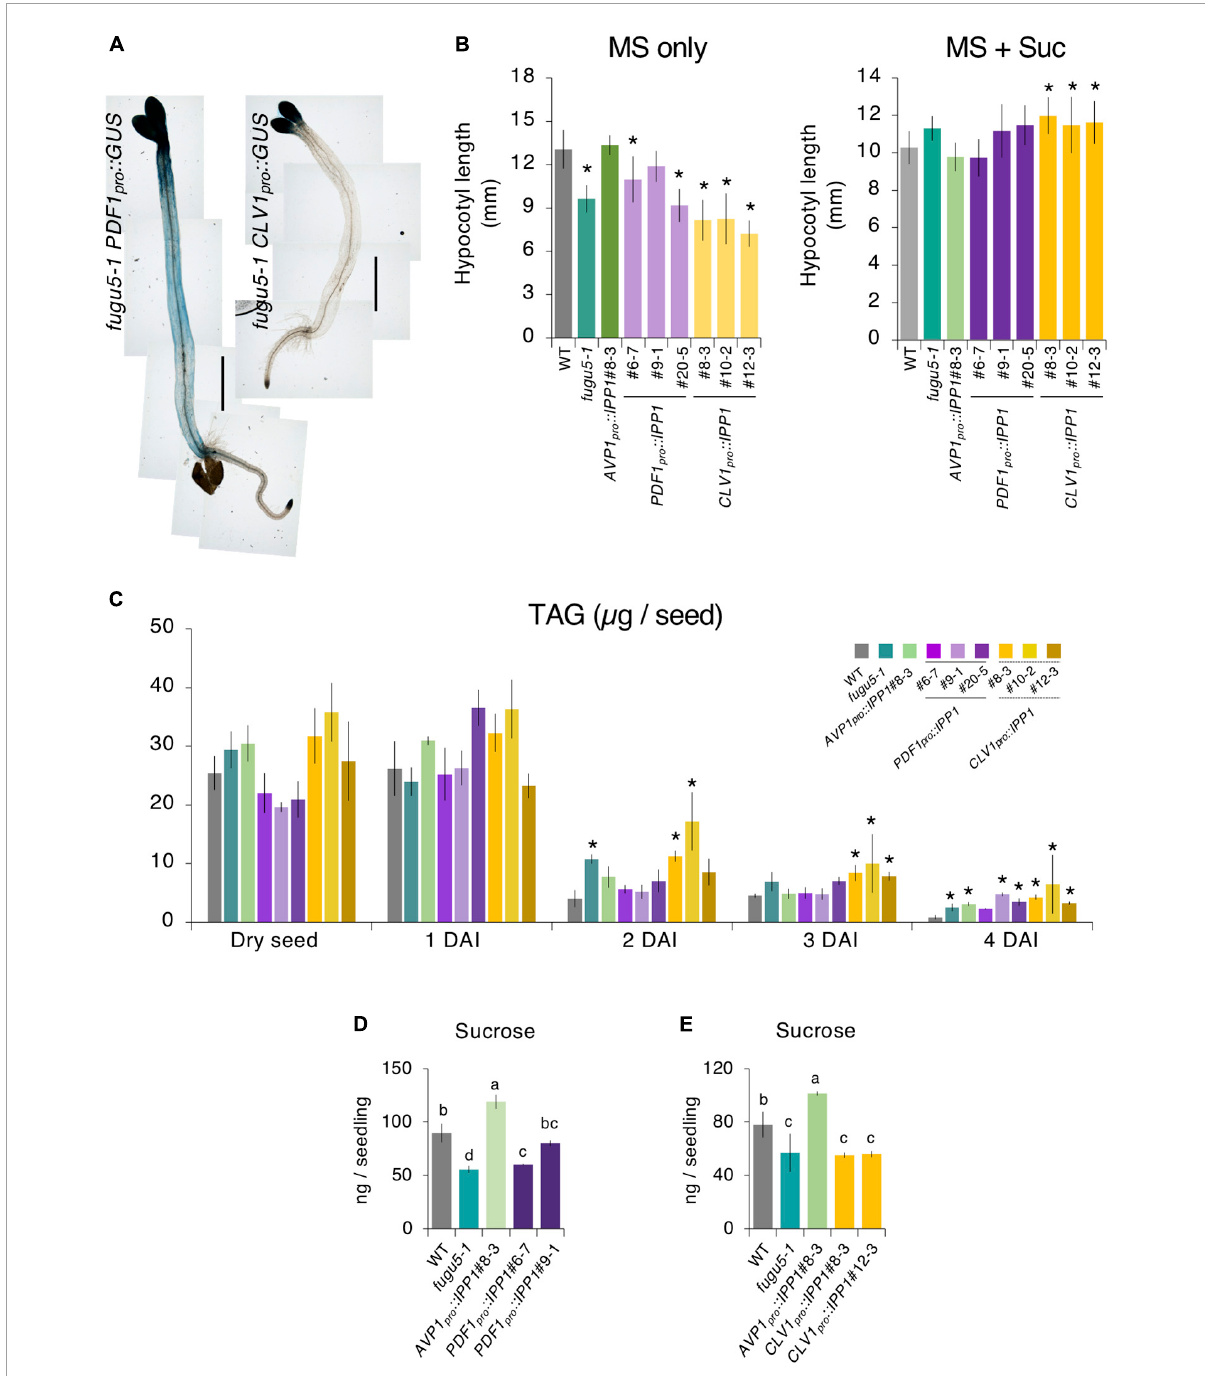
FIGURE3 Etiolated seedling elongation and triacylglycerol (TAG) mobilization in transgenic plants expressing IPP1 in a tissue-specific manner. (A) Micrographs of GUS staining of etiolated seedlings of the fugu5-1 PDF1 pro ::GUS and fugu5-1 CLV1 pro ::GUS lines grown on MS medium in darkness for 4 DAI. Scale bar = 1 mm. (B) Length of hypocotyls of the wildtype (WT), fugu5-1 , AVP1 pro ::IPP1 #8-3, PDF1 pro ::IPP1 , and CLV1 pro ::IPP1 lines grown on MS only and MS + Suc medium in the dark for 4 DAI. Data are means ± SD ( n = 21). *Significant difference at p < 0.05 compared to the WT (Tukey’s HSD test). (C) Mobilization of seed lipid reserves during post-germinative growth. The TAG content was quantified with 20 dry seeds or 20 etiolated seedlings at 1, 2, 3, and 4 DAI. Data are means ± SD ( n = 3 independent experiments). *Significant difference at p < 0.05 compared to the WT (Tukey’s HSD test). (D,E) Sucrose levels determined by GC-MS/MS of 100 etiolated seedlings at 3 DAI. Data are means ± SD ( n = 3 independent experiments). Each character represents a significant difference at p < 0.05 (Tukey’s HSD test). DAI, days after induction of seed